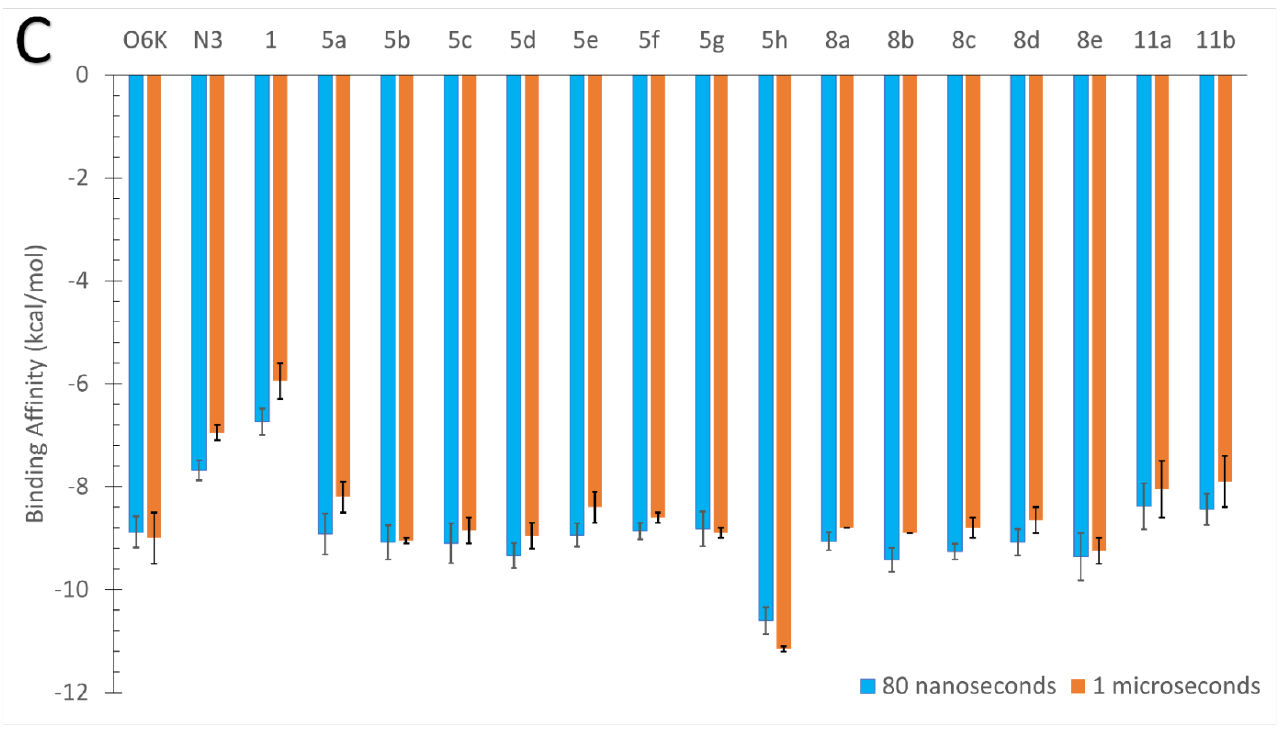
Figure 4. Comparison between the 80 ns and the 1 microsecond trajectories. ( A ) The root-mean- square deviation versus the simulation time. ( B ) The superposition of the most abundant confor- mation over the 1 microsecond trajectory (red cartoon) with the five different conformations of the 80 ns trajectory (other colored cartoons). ( C ) The average binding energies were calculated using AutoDock Vina over PyRx software (blind) for both systems. Error bars represent the standard de- viation.